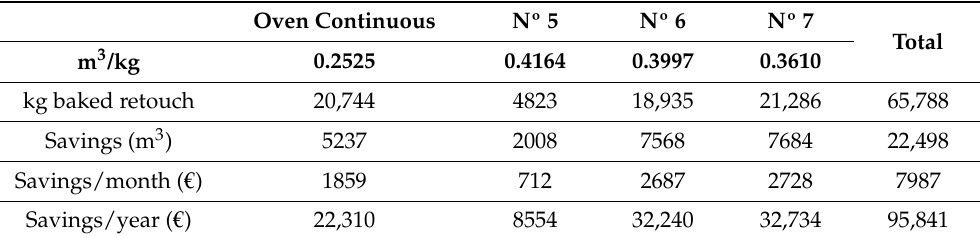
Table 6. Annual savings from a one percentage point reduction in retouching. Oven Continuous Nº